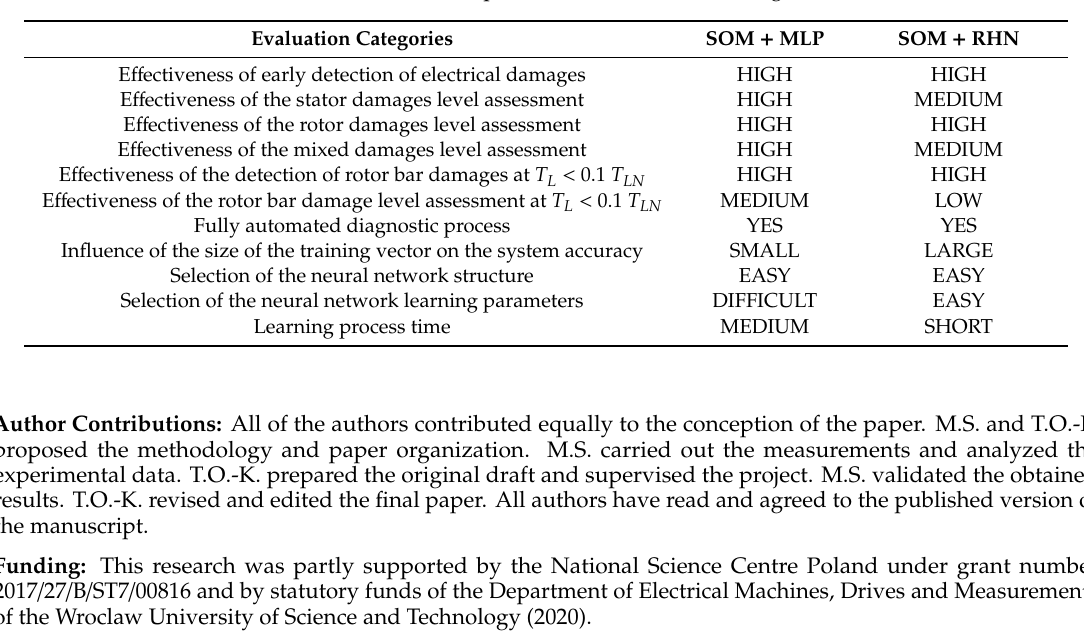
Table 8. Evaluation of the developed CdNN-based IM winding fault